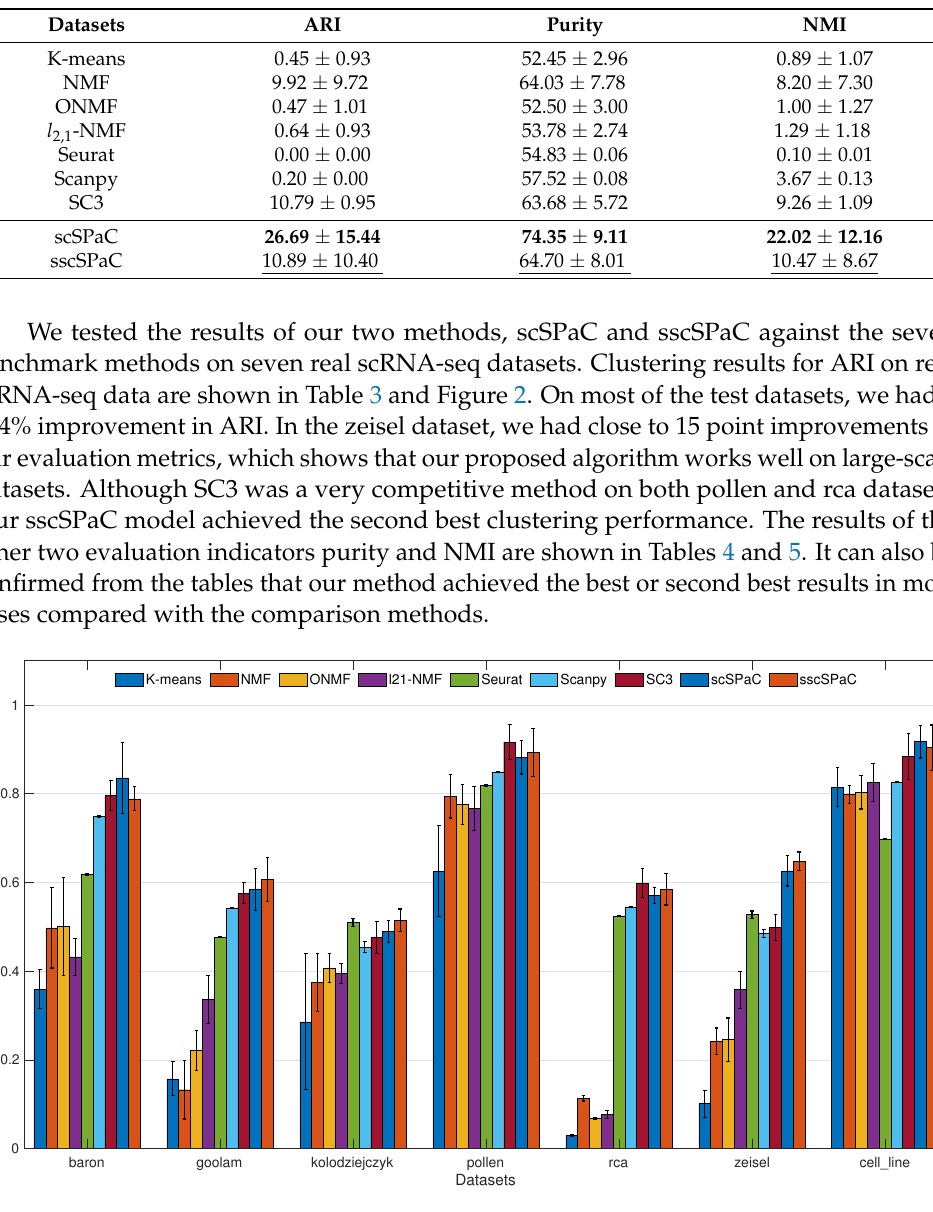
Figure 2. ARI for all test datasets in this study. Bar: average ARI; Errbar: standard deviation of ARI values for 20